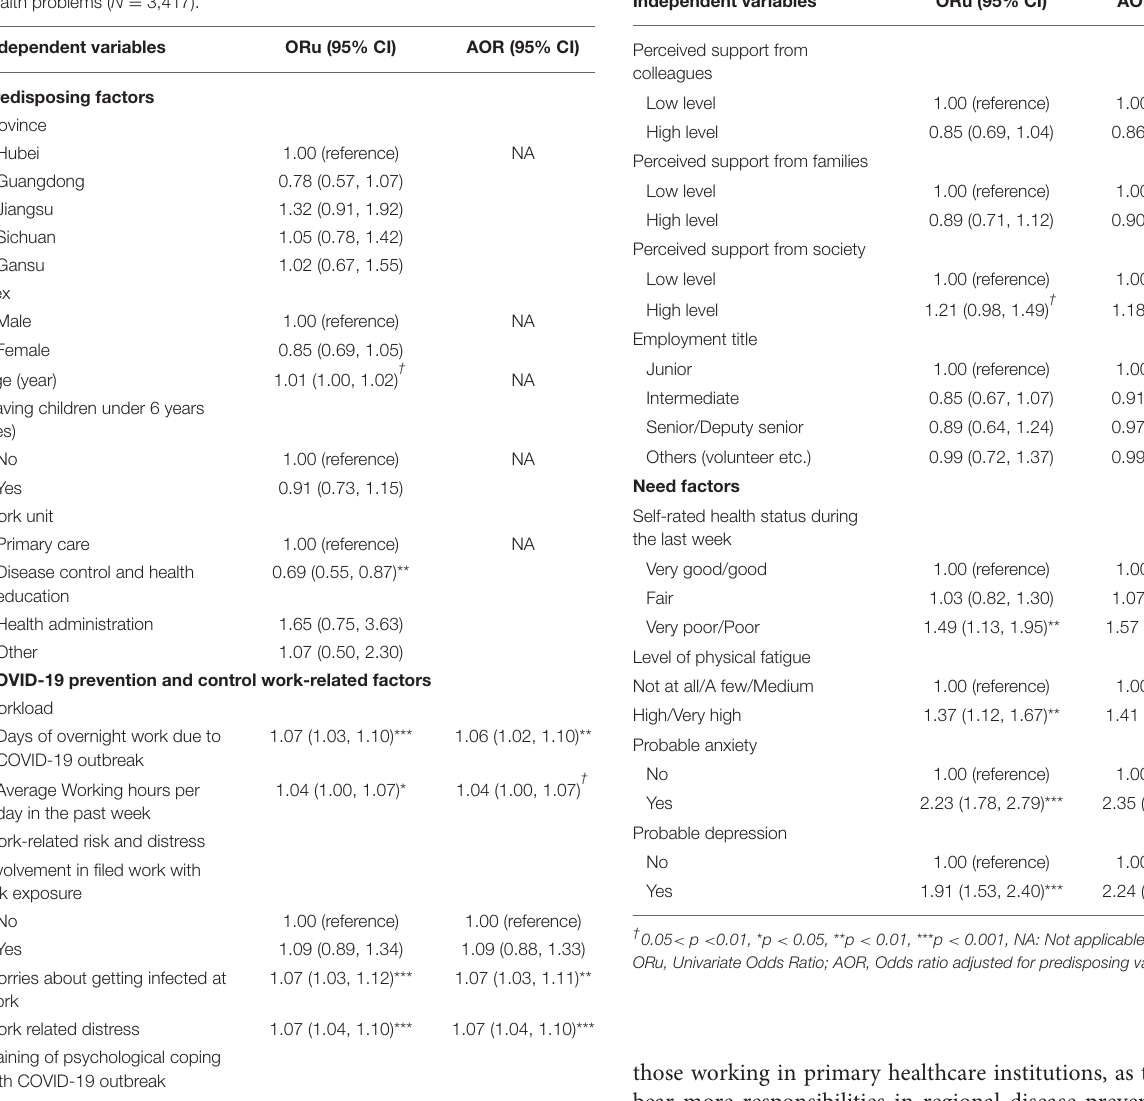
TABLE 2 | Univariate and multivariate analysis of factors associated with mental health help-seeking among public health workers who reported probable mental health problems ( N =